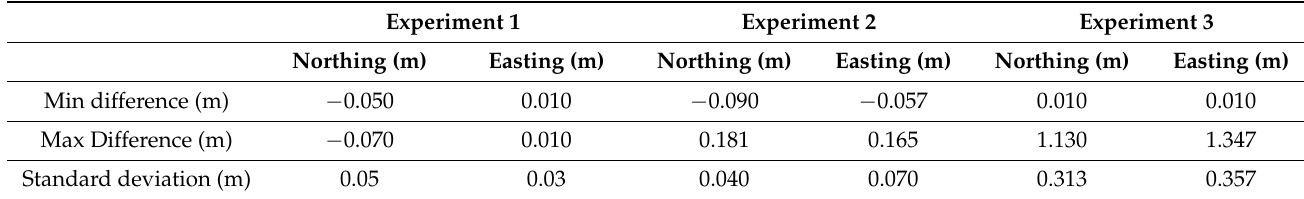
Table 5. Statistics for measured coordinates in all